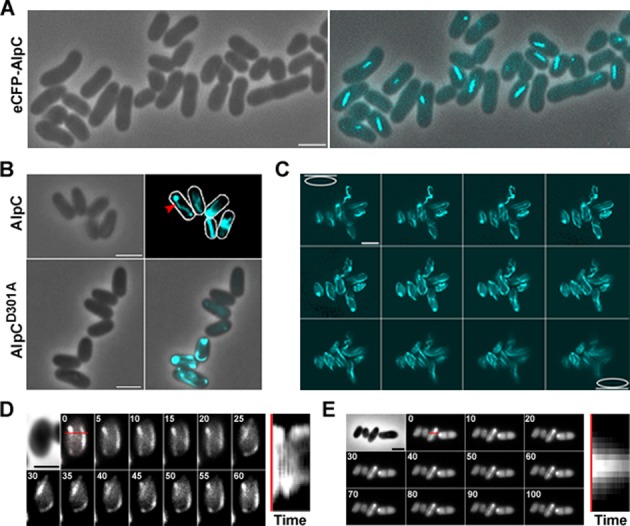
AlpC assembles into filaments in C. glutamicum. (A) eCFP-AlpC (CDC020) assembles into short, straight filaments when expressed at physiological concentration. Cells were grown in CGXII containing 4% glucose. Excision of the CGP3 prophage was induced with 0.6 μg/ml mitomycin C for 3 h prior to microscopic analysis. (B) AlpC-CFP (CDC021) assembles into long, curved filaments when overproduced in C. glutamicum, red arrowhead. Cells were grown in BHI and induced by addition of 0.5 mM IPTG 1 h prior to microscopic analysis. Mutation of the conserved aspartic acid of the phosphate 2 motif of AlpC reduces filament assembly (AlpCD301A-CFP, CDC022) (lower panel). (C) Z-stack analysis of the subcellular distribution of AlpC-CFP (CDC021) filaments. Cells overproducing AlpC-CFP contain numerous filaments of various orientation, curvature and length (Movie S1). (D) AlpC-CFP filaments are dynamic. Images were acquired at 5 s intervals (top left) for 1 min (Movie S2). The red line denotes the position in the cell used to generate the kymograph (right). (E) AlpCD301A-CFP filaments are static. Images were acquired at 5 s intervals (top left) for 100 s (Movie S3). As in (C), a kymograph is shown on the right. Scale bar, 2 μm